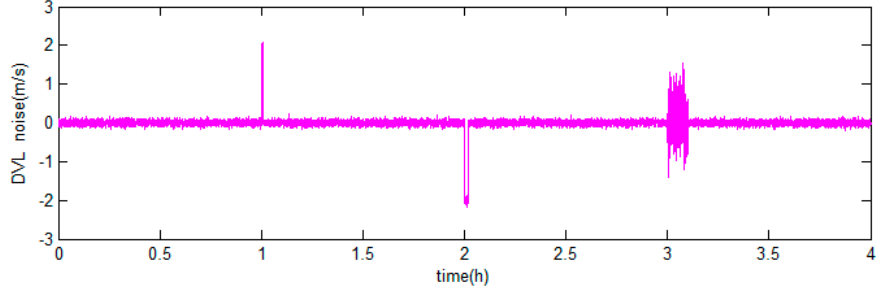
Figure 12. The Doppler velocity log (DVL) output errors of the simulation experiment.